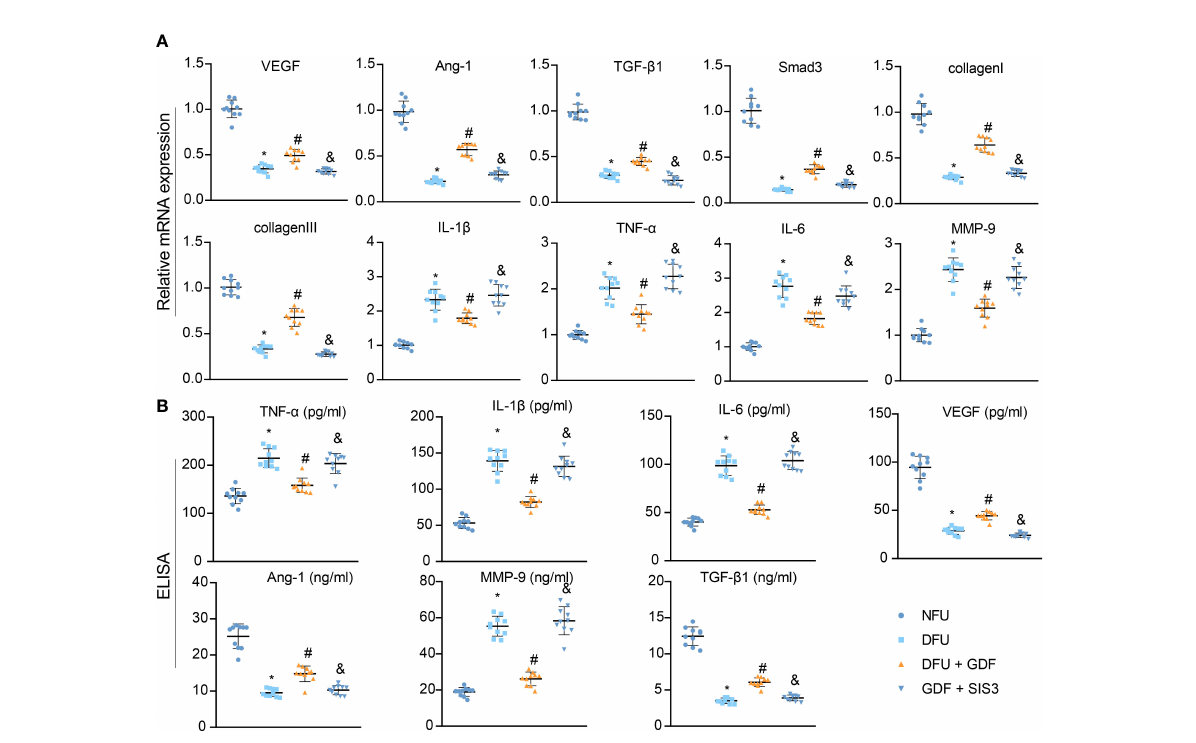
FIGURE 7 Effects of GDF10-stimulated angiogenesis on the wound healing-related factors in DFU rats. (A) , RT-qPCR for detecting mRNA expression of Smad3, VEGF, Ang-1, TGF- b 1, collagenI, collagenIII, IL-1 b , IL-6, TNF- a , and MMP-9. (B) , ELISA for determining expression of VEGF, Ang-1, TGF- b 1, IL-1 b , IL-6, TNF- a , and MMP-9. Measurement data were expressed in the form of mean ± standard deviation. One-way ANOVA was used for comparison between multiple groups, and repeated measures ANOVA was used to compare data between groups at different times. * p < 0. 05 vs. the NFU group. # p < 0.05 vs. the DFU group. & p < 0.05 vs. the DFU + GDF group. Ten rats were used in each